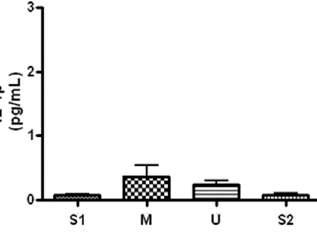
Figure 8. Serum IL-1 β concentration in different locations. Values are mean ± S.D. S1: Before start in Seoul, M: Moscow U: Ulaanbaatar S2: Return to